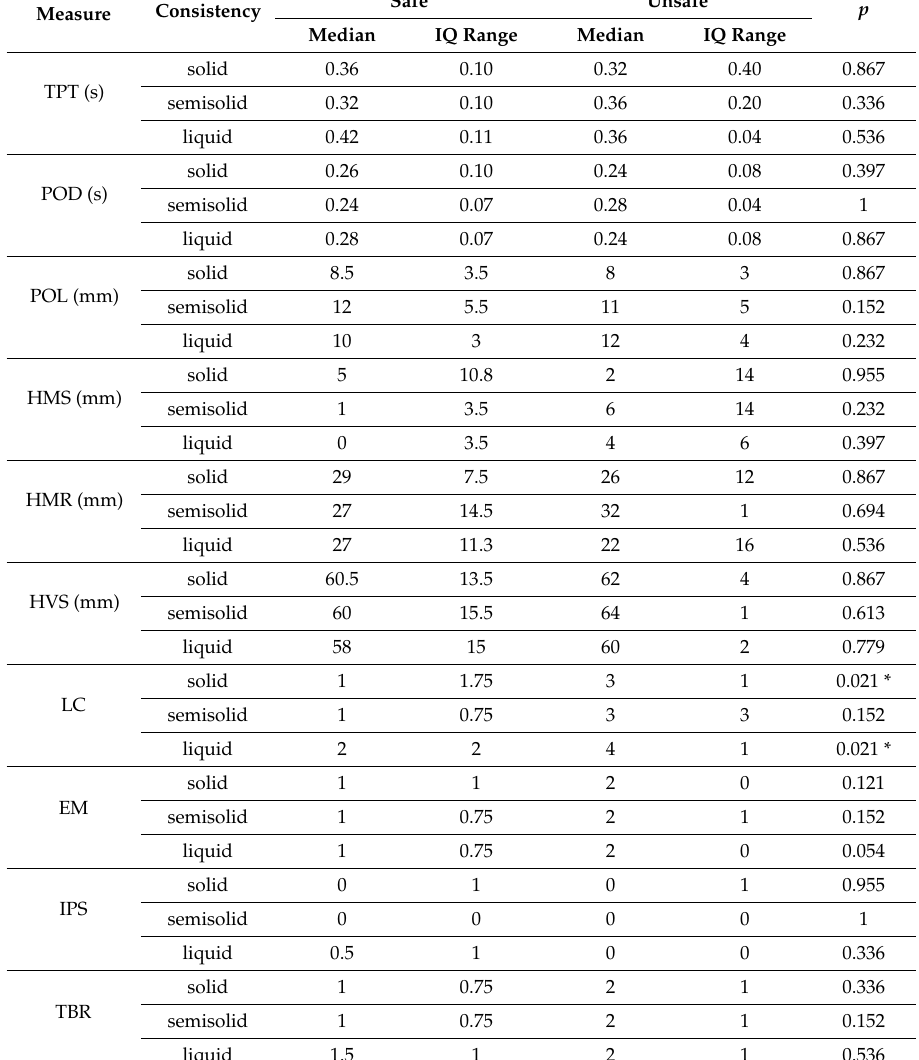
Table 1. Comparisons of videofluoroscopic measures in patients with safe and unsafe